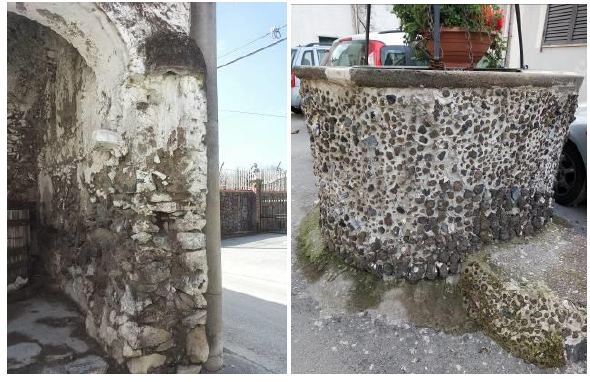
Figure 21. Lava masonry and water well (Boccia al Mauro,